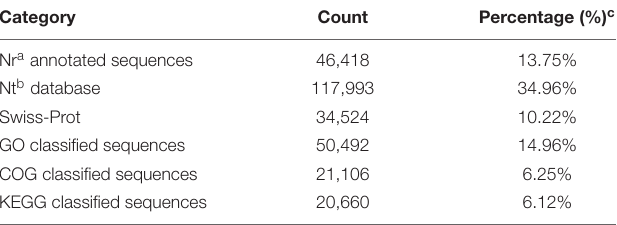
TABLE 2 | Annotation of assembled G. eckloni gene